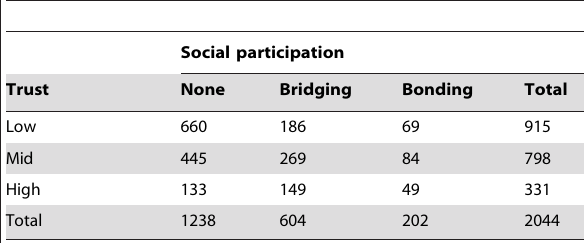
Table 1. Characteristics of study subjects in Okayama, Japan (2009).